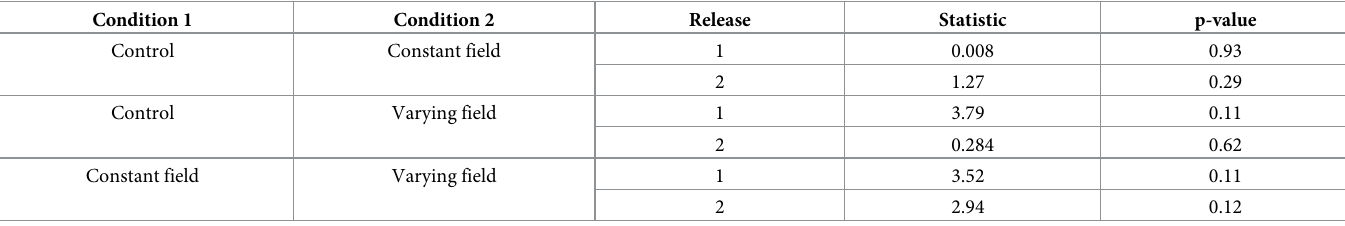
from each other (Table 1 for the comparison of all 3 groups; Table 2 for pairwise comparisons of groups), although there was a trend for the varying field group to be more different than the others on the first release. The deviation angles from the vanishing bearings to the mean bearing for each group showed a significantly higher scatter for pigeons in the varying field condition compared to the constant field (p = 0.01) and the control group (p = 0.0003) (Fig 1; Table 3). The difference Table 2. Results of testing difference in mean vanishing bearings after first and second releases between pairs of experimental conditions, using the YgTestBoot function from